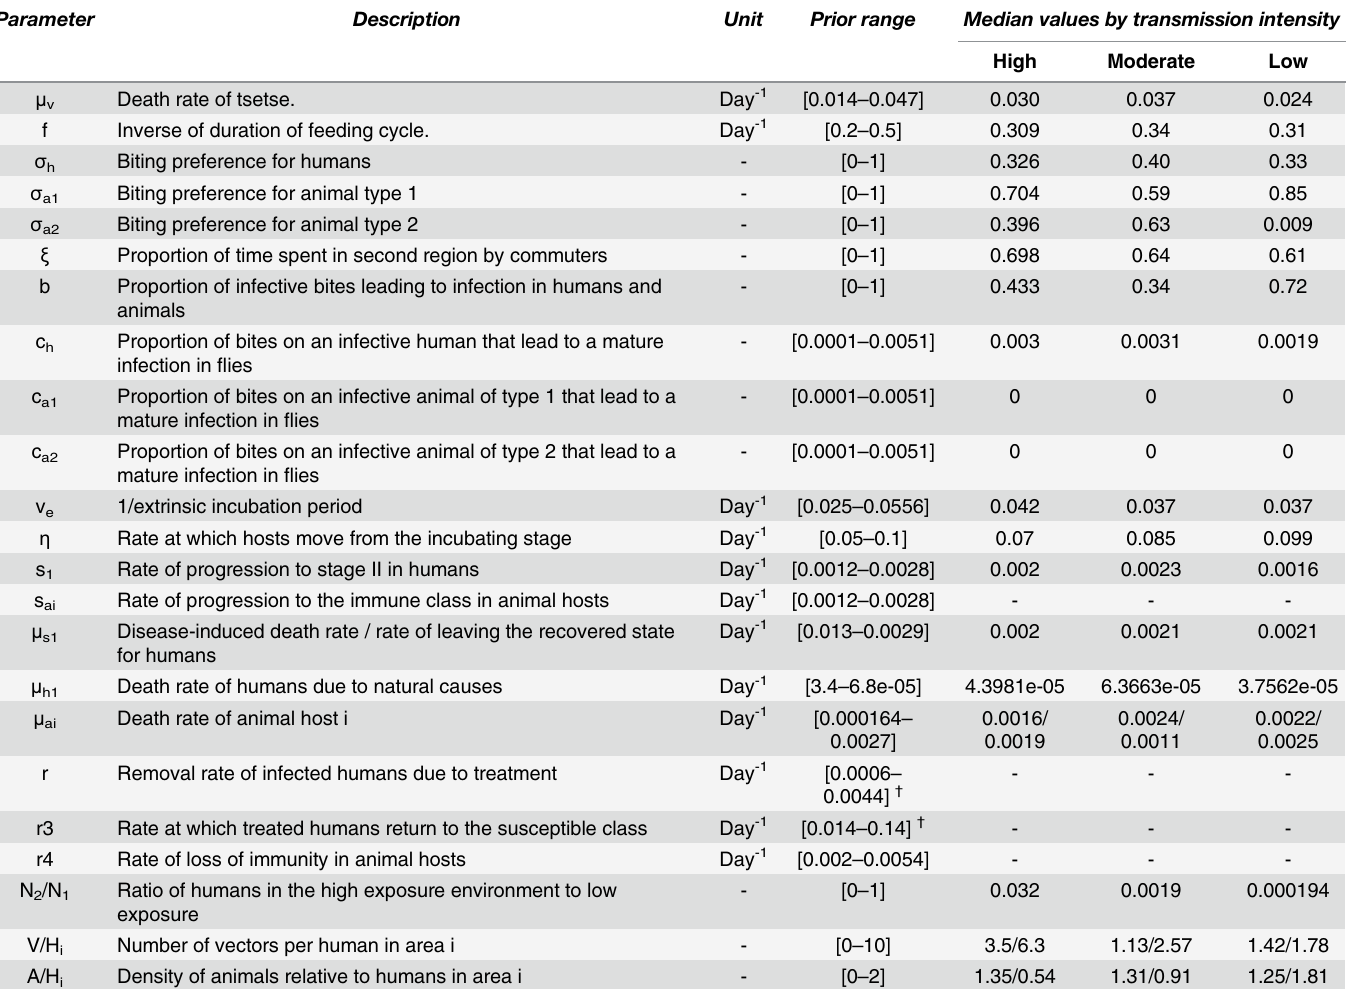
Table 2. Rate parameter descriptions, values used and ranges for model versions based on heterogeneity, but no animal